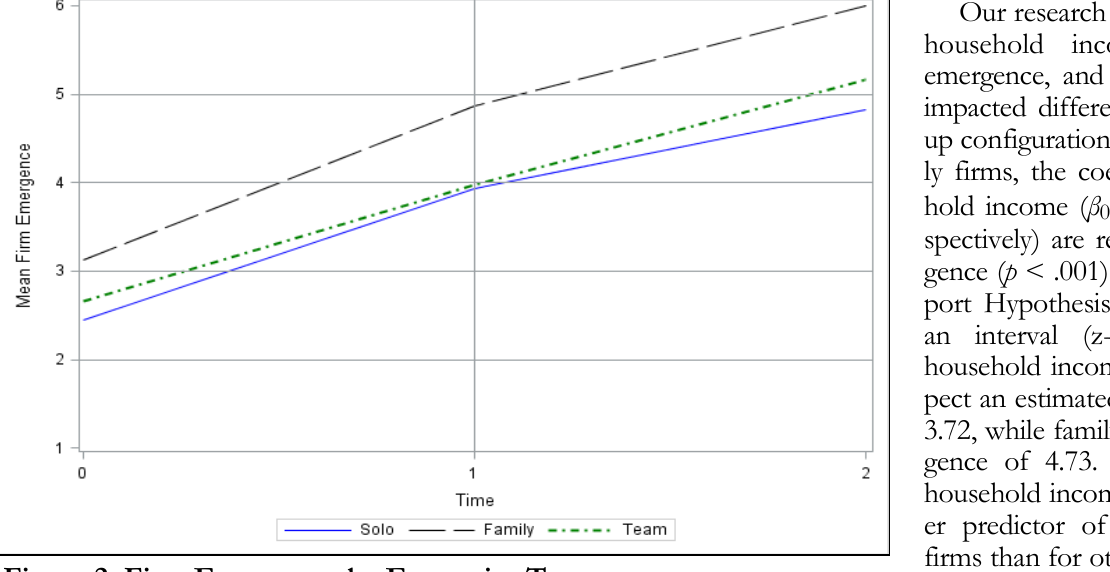
Figure 2. Firm Emergence by Enterprise Type